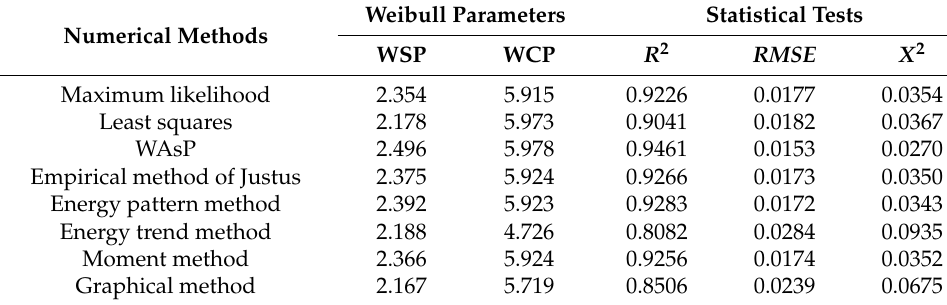
Table 6. Weibull parameters and statistical analysis for Ormara.